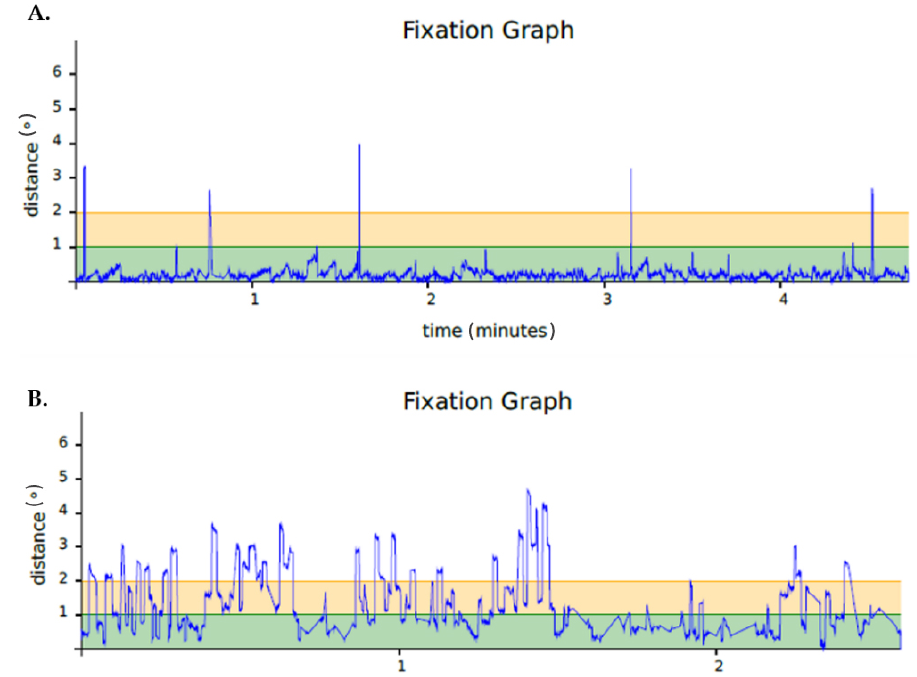
Figure 1. ( A ) Fixation graph of a DLC patient at the beginning of the study. ( B ) Fixation graph of the same patients with follow-up at 12 months.